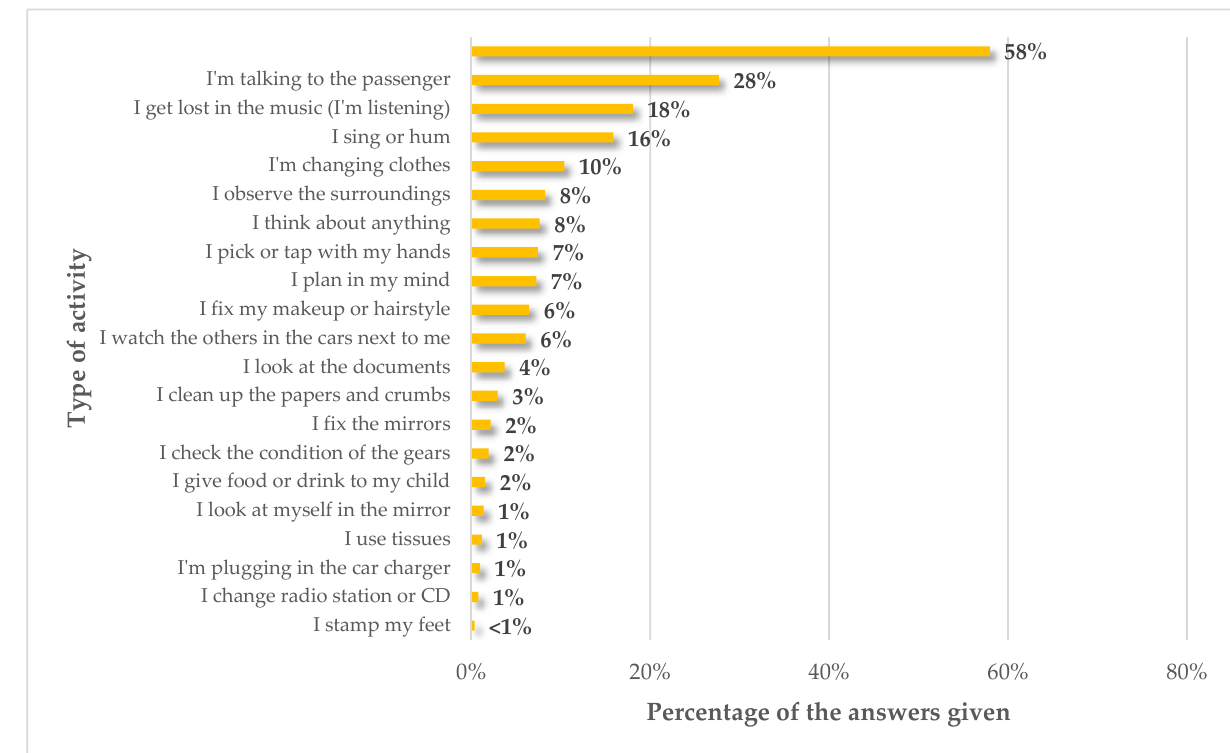
Percentage of the answers given Figure 4. Other activities that drivers perform while waiting for the green signal. Statistical significance was analyzed for various groups of people in terms of sex and age group. Due to the small number of responses in the group of respondents aged over 70, their results were combined with the group aged 50–70. The statistical analysis was performed with the Kolmogorov–Smirnov lambda test. The distribution of the obtained responses in individual groups of people was compared, at the alpha significance level of 5%.